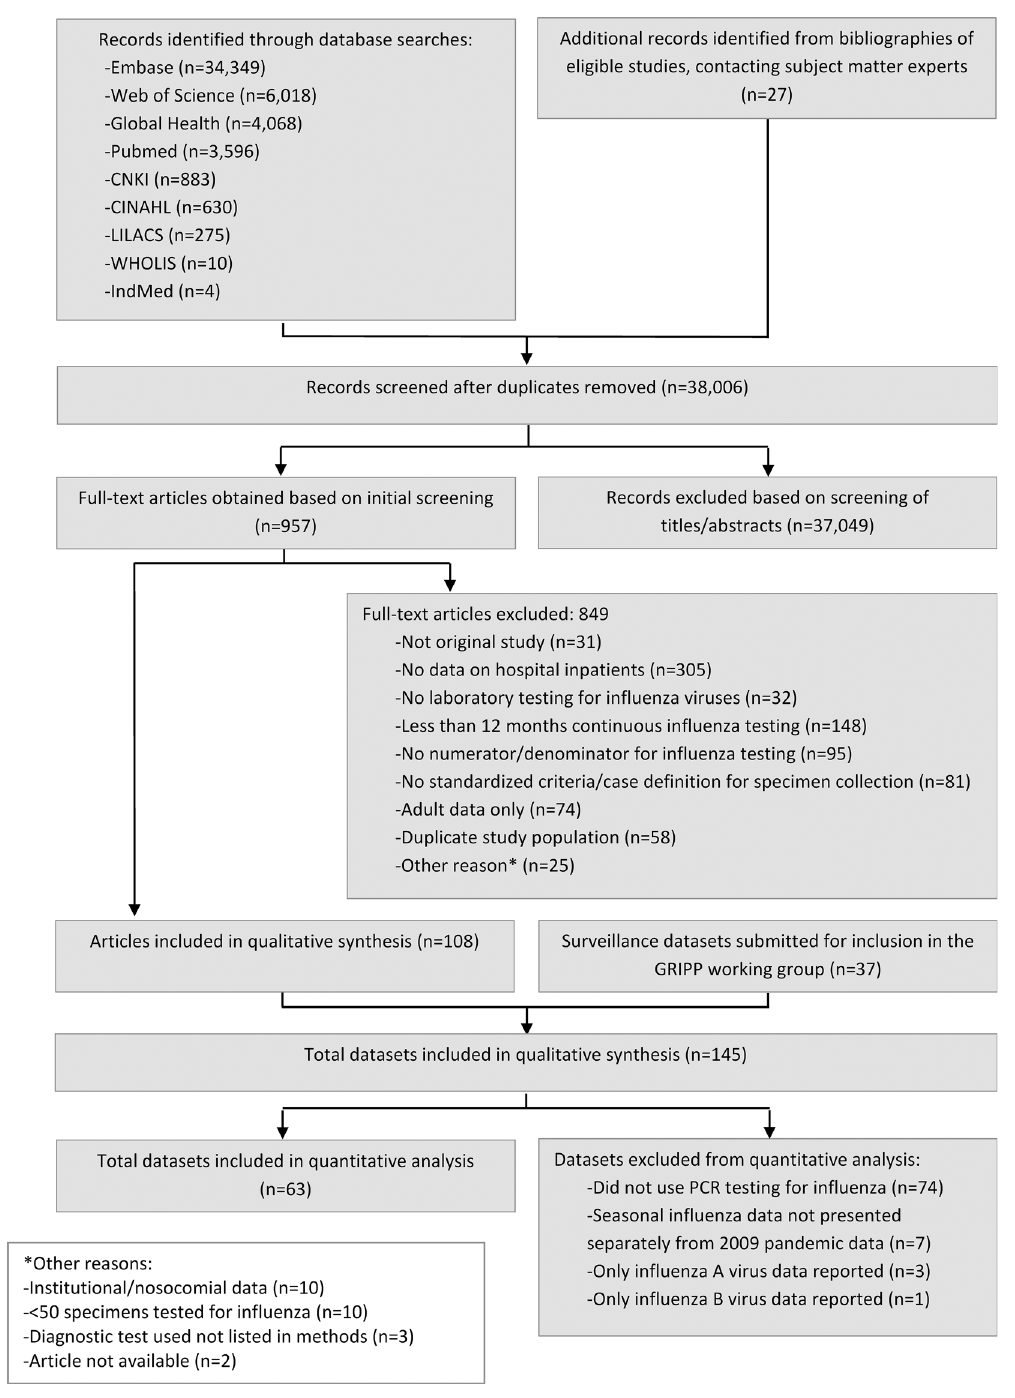
Fig 1. Flow diagram for systematic review